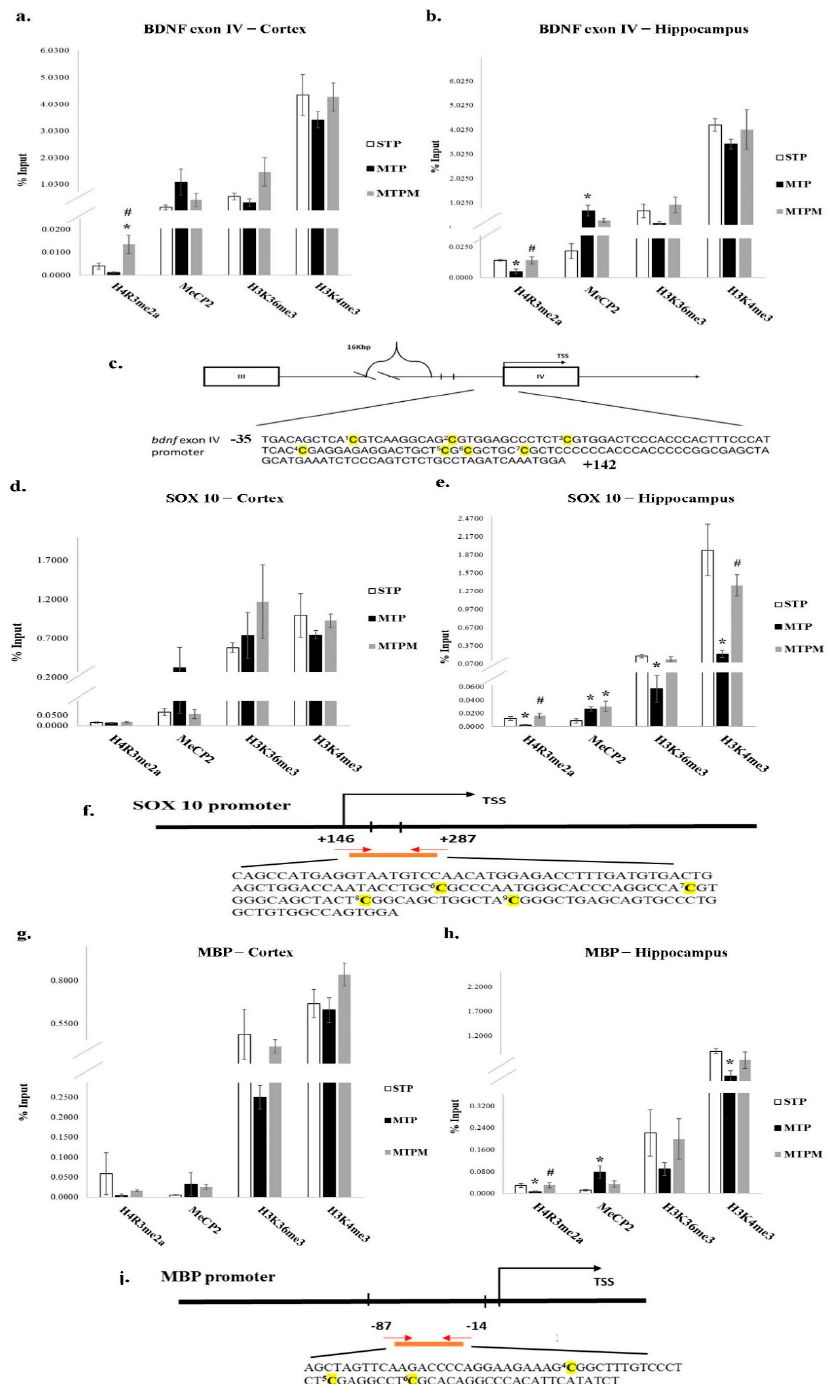
Figure 4. MTX treatment altered epigenetic modification of BDNF exon IV and myelination-related gene promoter, however, melatonin prevented the alteration induced by MTX. ( a ) ChIP exam for BDNF exon IV promoter revealed decrease in the level of H4R3me2a and increase in the level of MeCP2 inbrain cortex. ( b ) ChIP exam for BDNF exon IV revealed significant decrease in the level of H4R3me2a and increase in the level of MeCP2 in the hippocampus and in the brain cortex, respectively. ( c ) BDNF IV promoter sequences for ChIP assay. ( d ) ChIP exam for SOX 10 promoter found less significant effect of MTX in brain cortex. ( e ) ChIP exam for SOX10 promoter found significant change in the levels of H4R3me2a, MeCP2, H3K36me3, and H3K4me3 in the hippocampus. ( f ) SOX10 promoter sequences for ChIP assay. ( g ) ChIP exam for MBP promoter decrease in the level of H4R3me2a and increase in the level of MeCP2 in brain cortex; ( h ) ChIP exam for MBP promoter revealed significant alteration of the expression levels in hippocampus. ( i ) MBP promoter sequences for ChIP assay. “C” highlights in bold with yellow background indicate variable CpG positions. (*: p < 0.05 vs. STP; #: p < 0.05 vs.